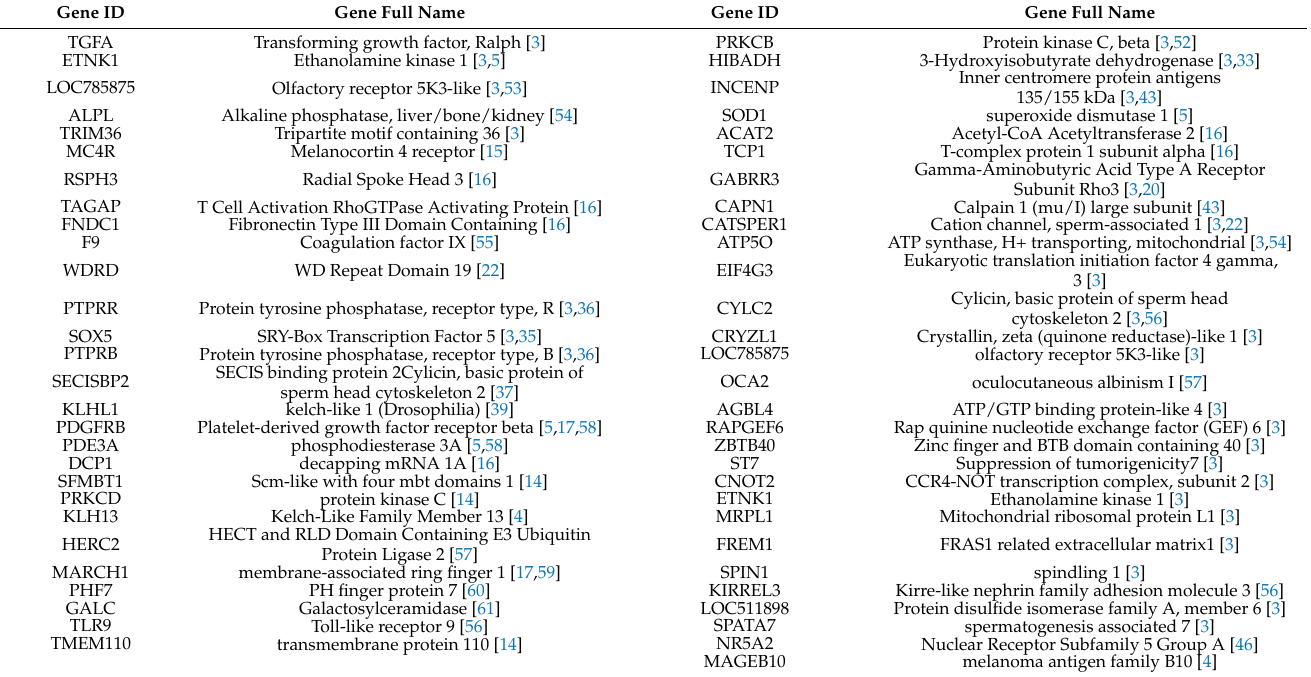
Table 5. Genes identified in this GWAS studies and their full